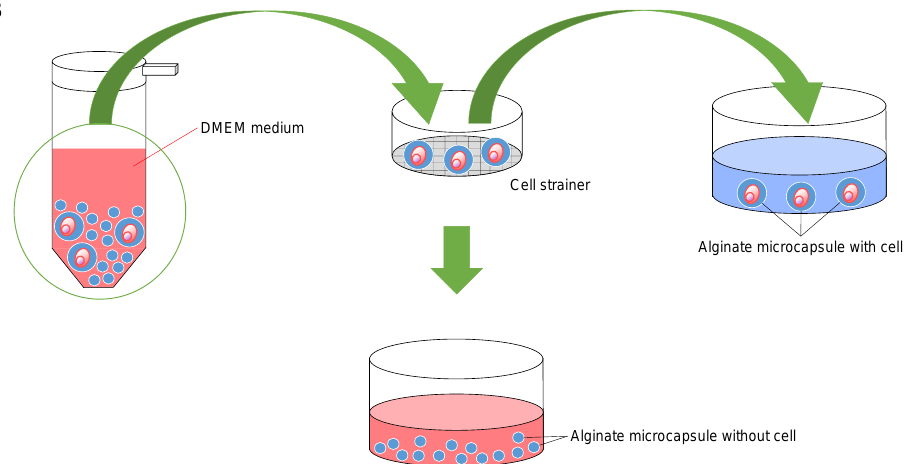
Figure 2. Centrifuge method for production of calcium alginate microcapsules. ( A ). Alginate microcapsule formation procedure. First, high viscous glycerin was filled into the tip of the tapered micropipette, then followed by the sodium alginate buffer containing cells. The micropipette was placed in the 1.5mL tube. After capsules of sodium alginate solution are produced by centrifugal force, they change into alginate microcapsules. ( B ). Separation of alginate microcapsules containing cells using a cell strainer. The mixture of alginate microcapsules with/without cells was separated by using 20µm cell